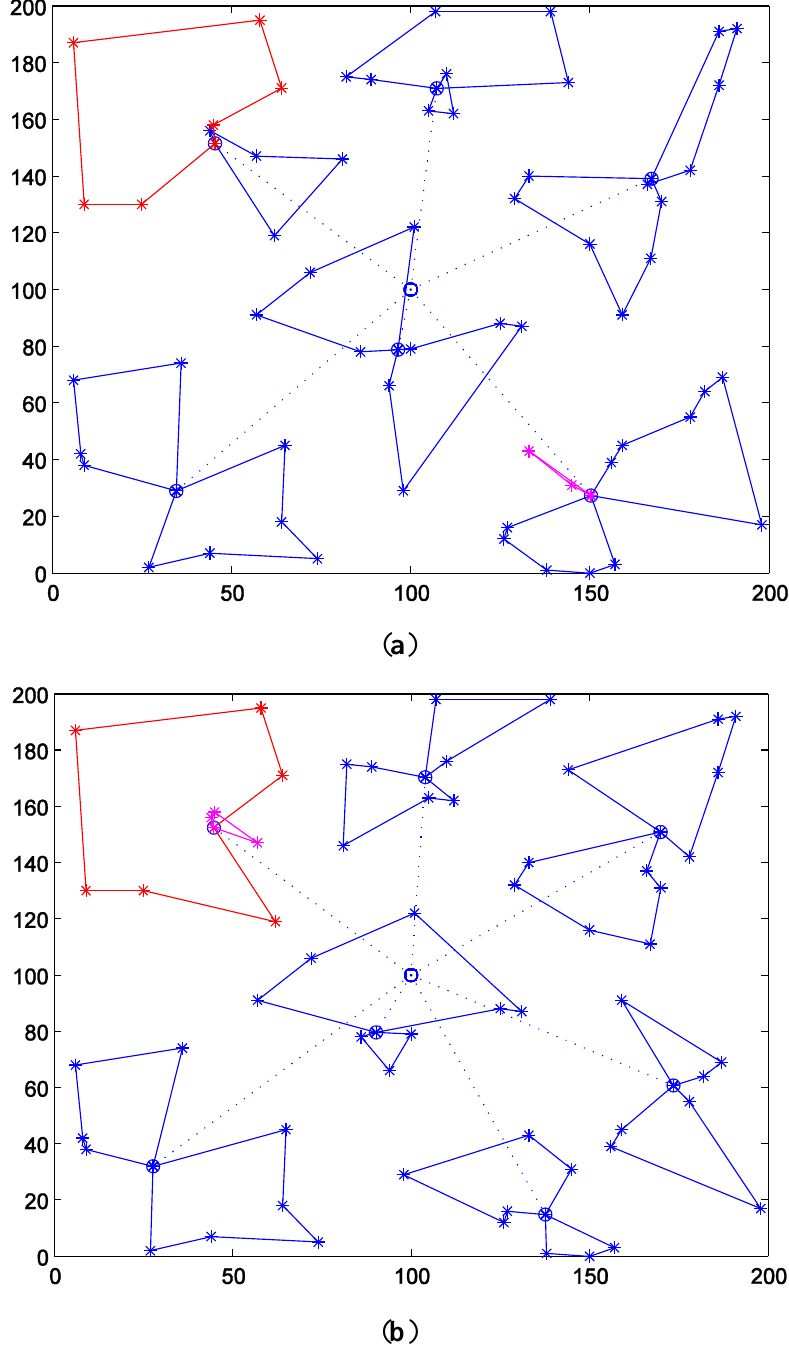
Figure 8. Intermodal transportation routes with six and seven TDCs ( Q =